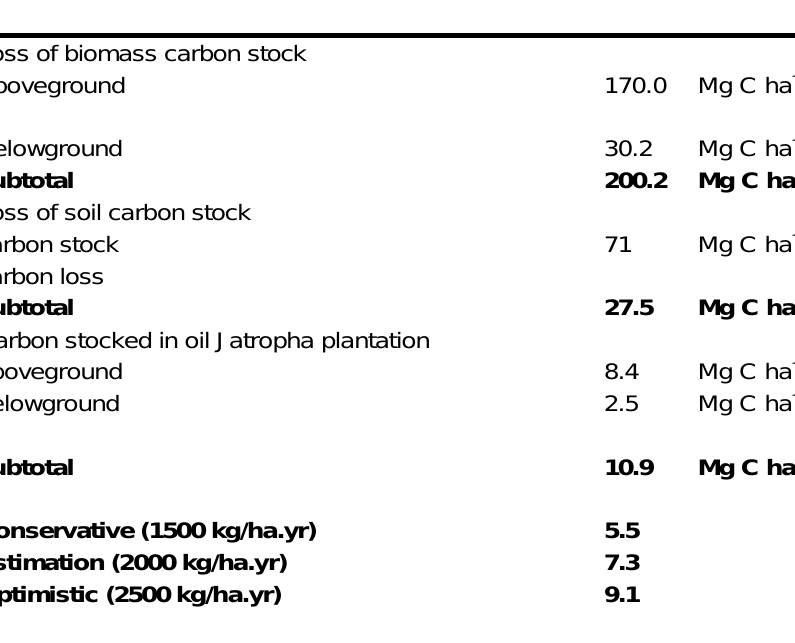
Table A4.3. Carbon debt calculation of Chiapas, Mexico